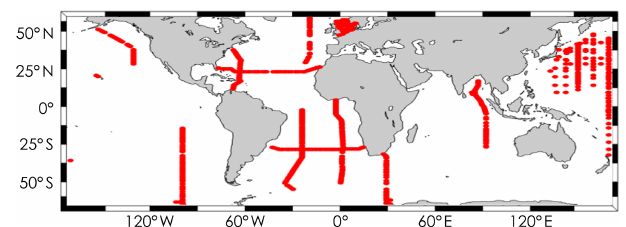
Figure 1. Spatial coverage of the dataset containing GLODAPv2 and SOCAT samples for which DIC, TA, pH, and p CO 2 are avail- able from independent, high-quality